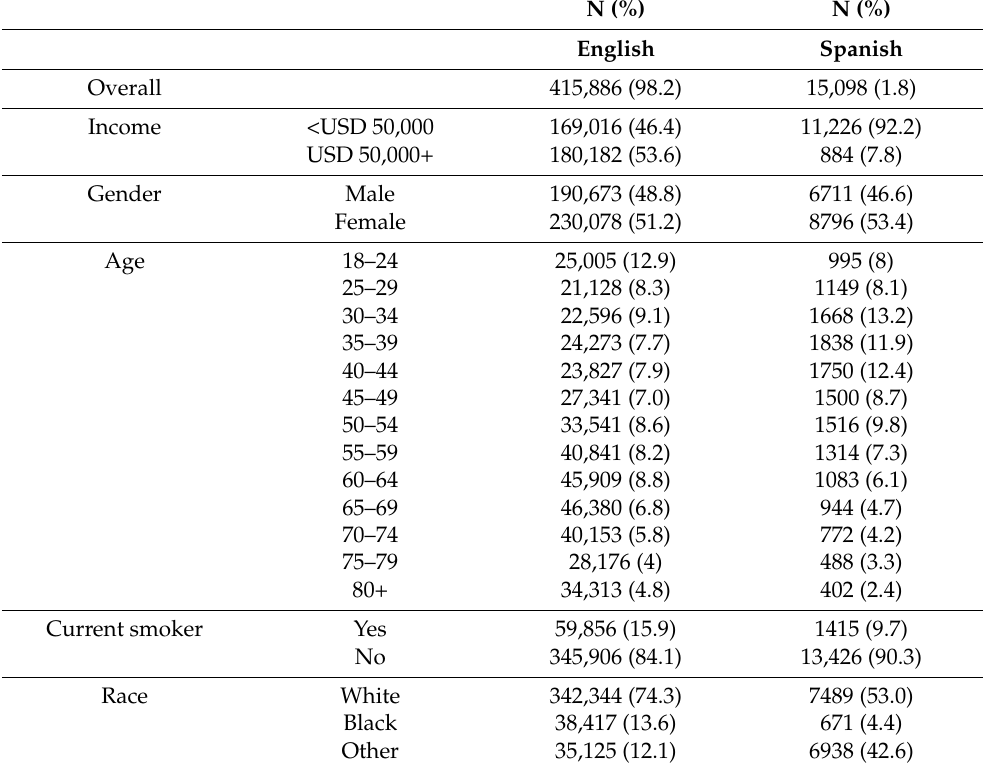
Table 1. Descriptive statistics for study sample overall and by native language (English vs.